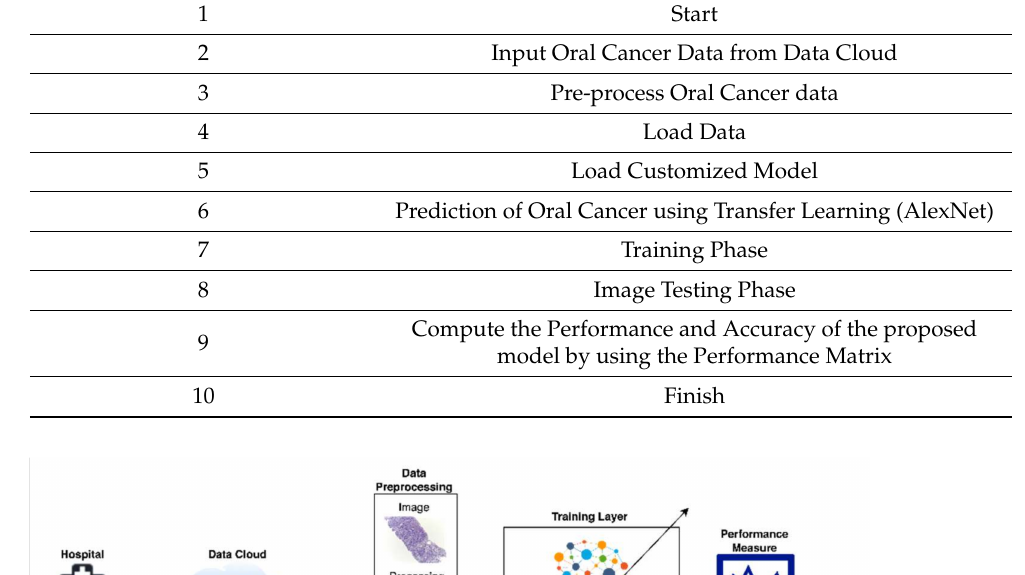
Table 2. Pseudocode of the proposed model for oral cancer prediction.